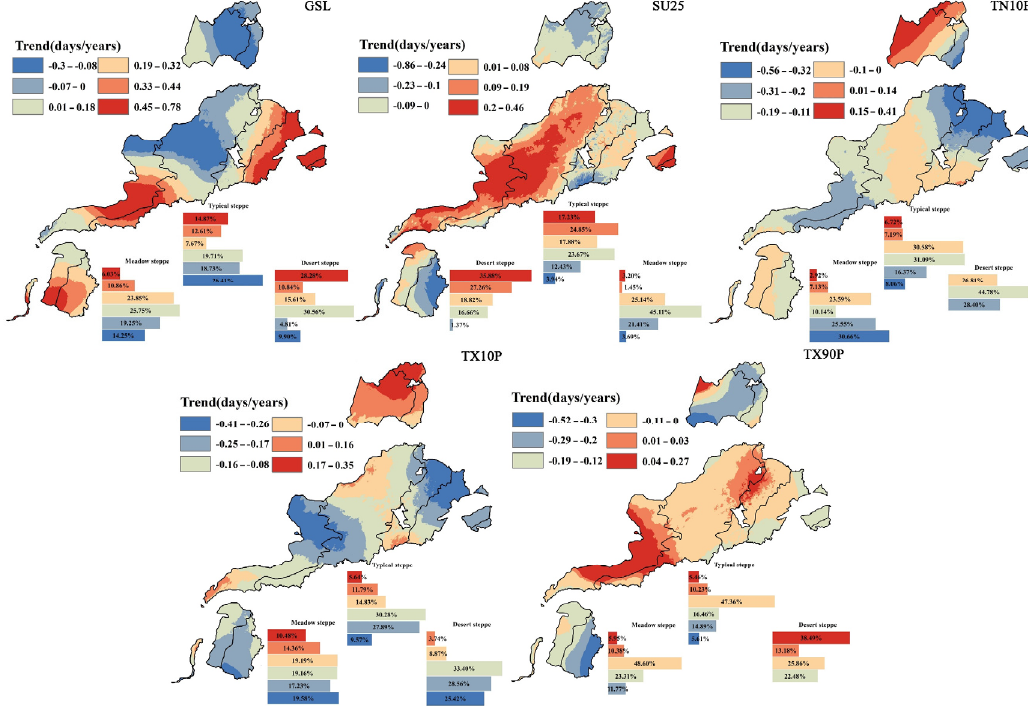
Figure 4. Spatial distribution of extreme temperature change in different steppe areas of Inner Mongolia from 1998 to 2017. Indices: GSL, growing season length; SU25, summer days; TN10P, cool nights; TX10P, cool days; TX90P, warm days.